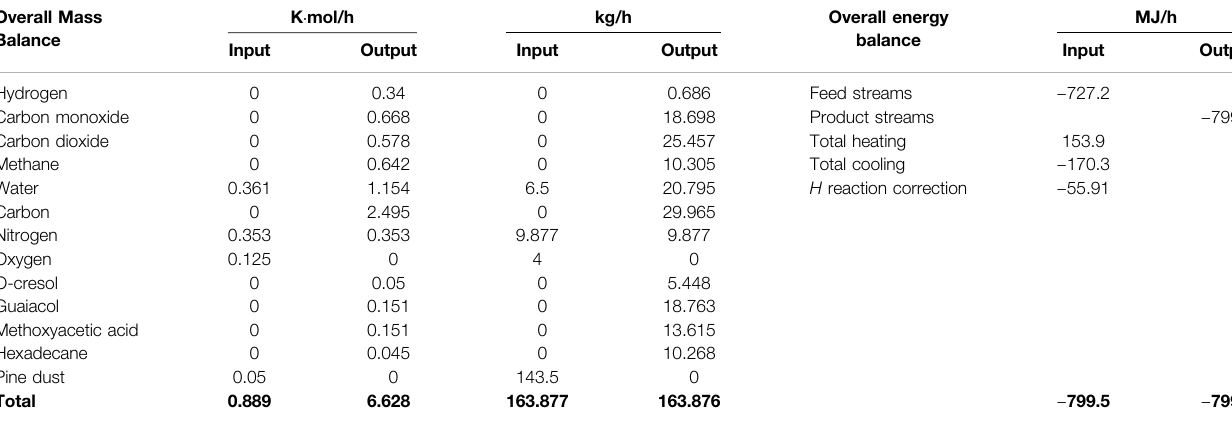
TABLE 4 | Overall energy and mass balances of the process. Overall Mass Balance